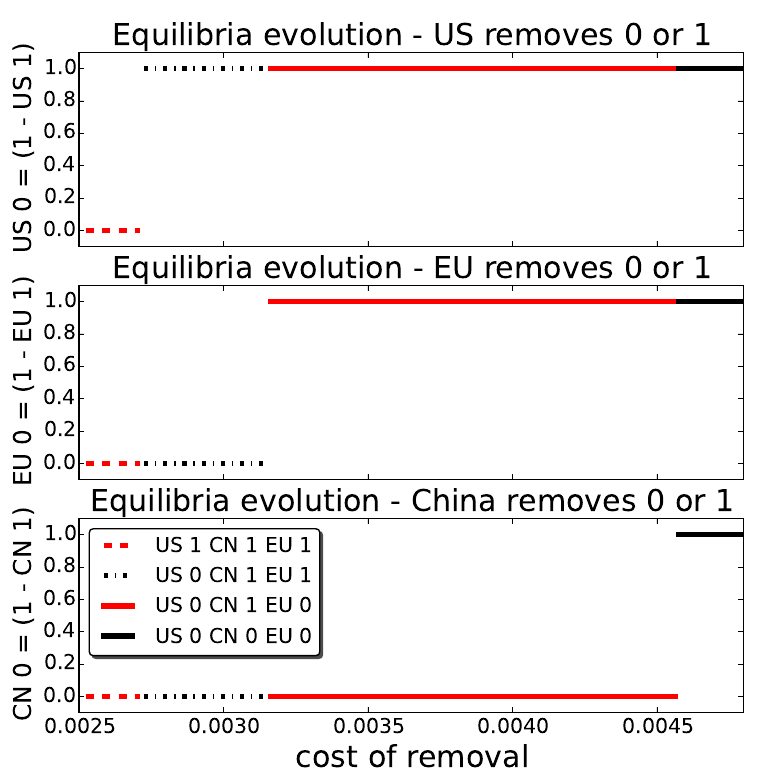
Figure 11. U.S., EU and China equilibria for different costs of